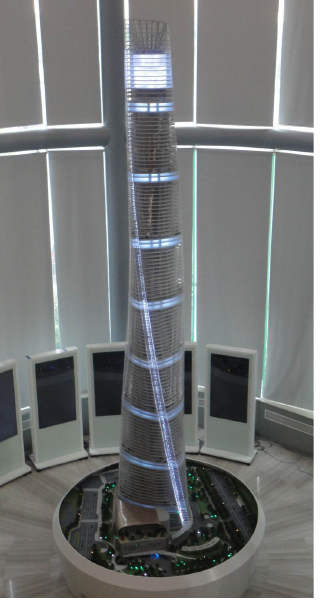
Figure 5. Shanghai Tower model (photo by Kyoung Sun Moon).